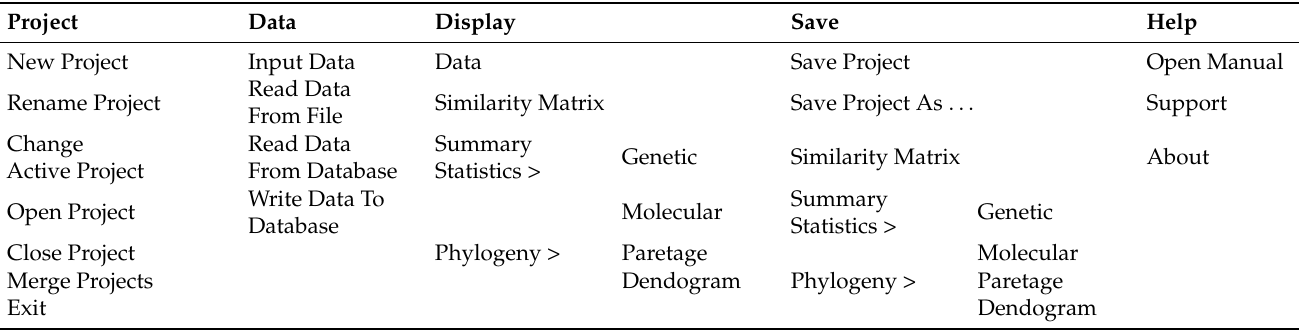
Table 1. Menu structure of